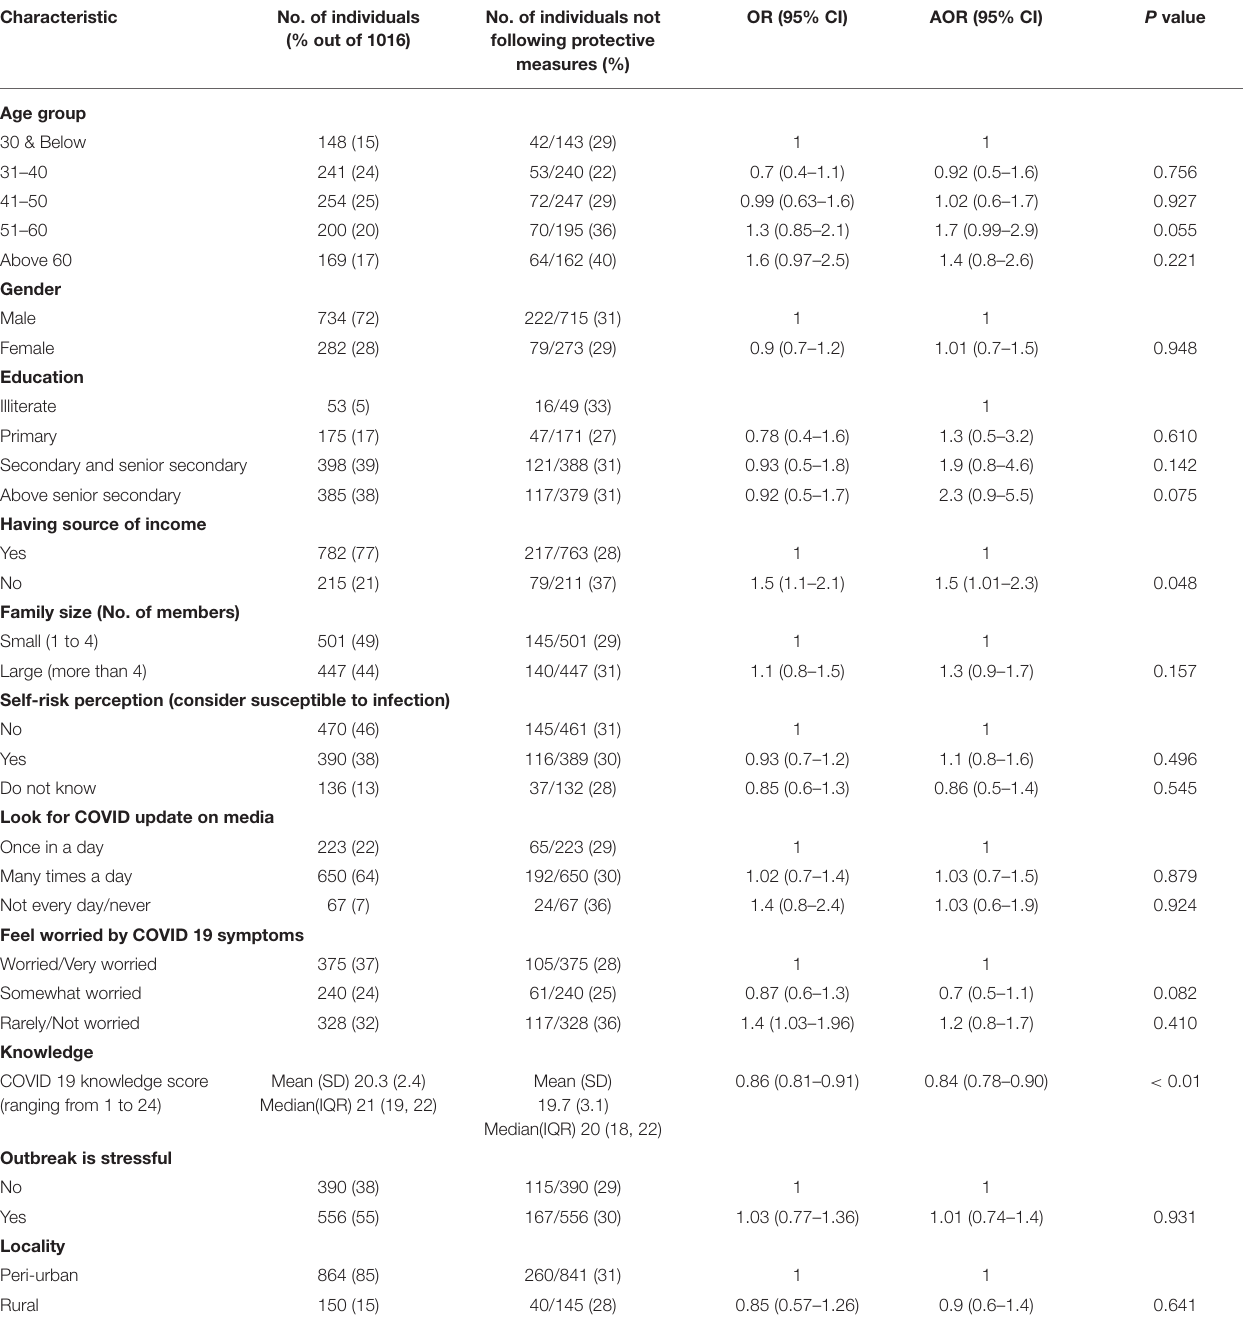
TABLE 6 | Association between socio-demographic variables and not following protective measures.